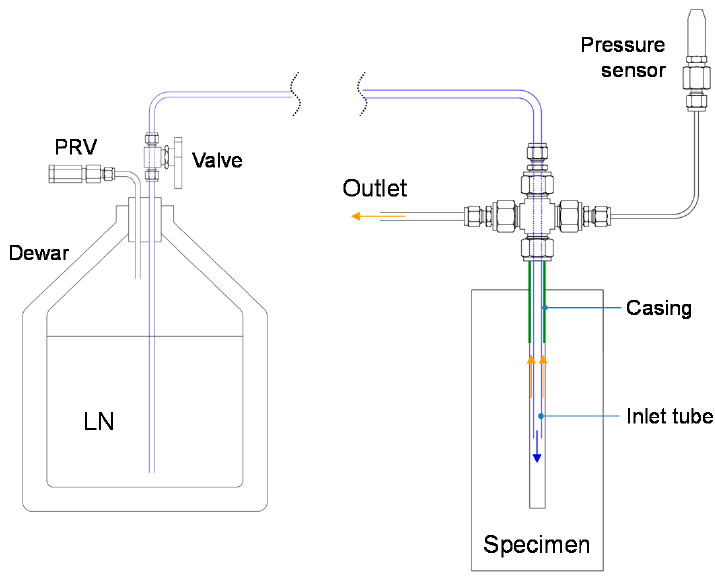
Figure 1. Experimental setup for cryogenic stimulation using liquid nitrogen.